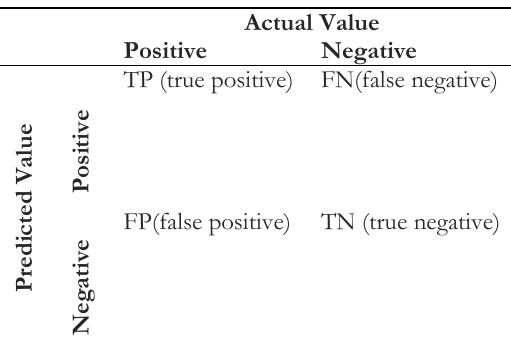
Table 2. Confusion